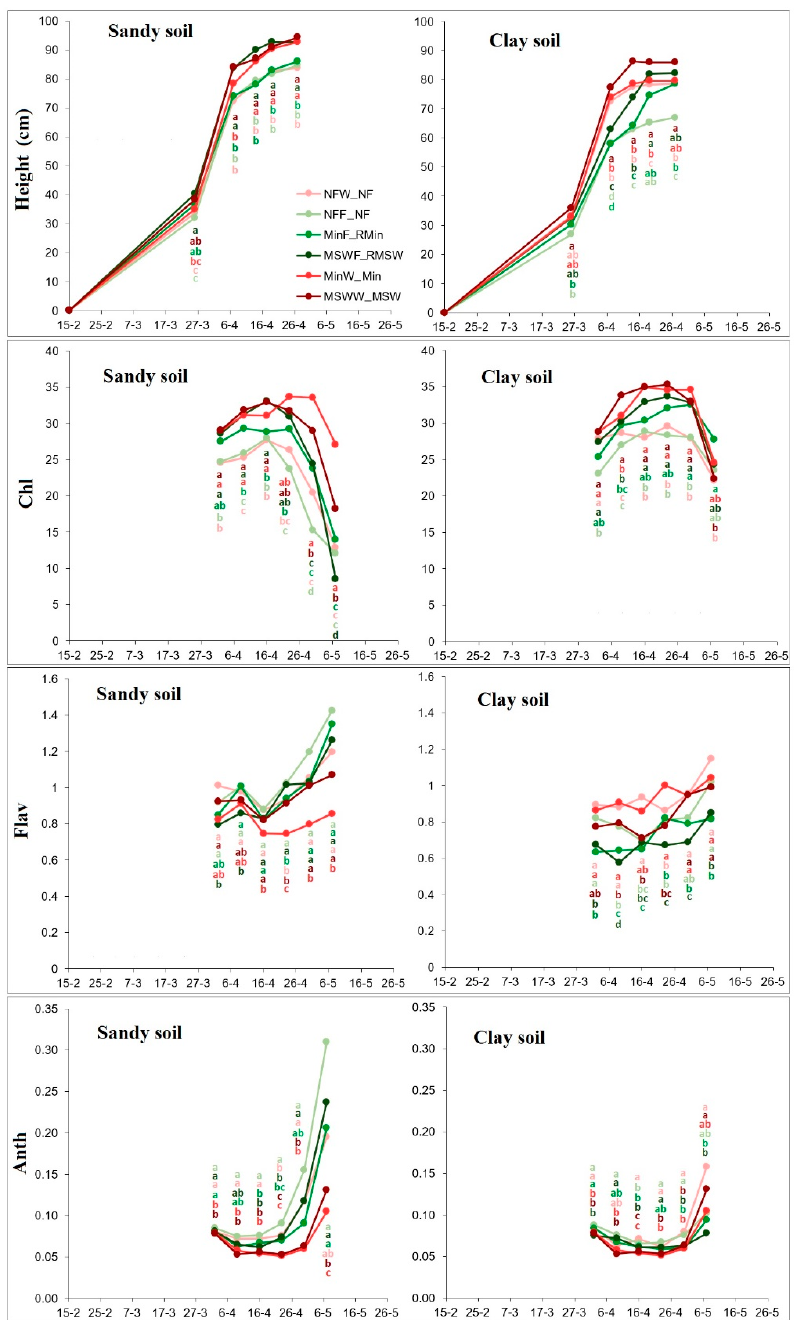
Figure 1. Effect of crop/fertilizer residual effect and present organic fertilization with bio-stabilized MSW amendment and mineral fertilization on buckwheat growth and pigment content (chlorophyll, Chl; flavonols, Flav; anthocyanins, Anth) under two different soils (clay and sandy) along the cropping season. Different letters for the same measurement and date represent differences among treatments ( p < 0.05, Tukey HSD test). NFW_NF: unfertilized wheat as precedent crop and without BW fertilization; NFF_NF: unfertilized faba bean as precedent crop and without BW fertilization; MinF_RMin: residual mineral fertilized faba bean as precedent crop and without BW fertilization, only residual fertilizer effect; MSWF_RMSW: MSW fertilized faba bean as precedent crop and without BW fertilization, only residual fertilizer effect; MinW_Min: mineral fertilized wheat as precedent crop and with present mineral BW fertilization; MSWW_MSW: MSW fertilized wheat as precedent crop and with present MSW BW